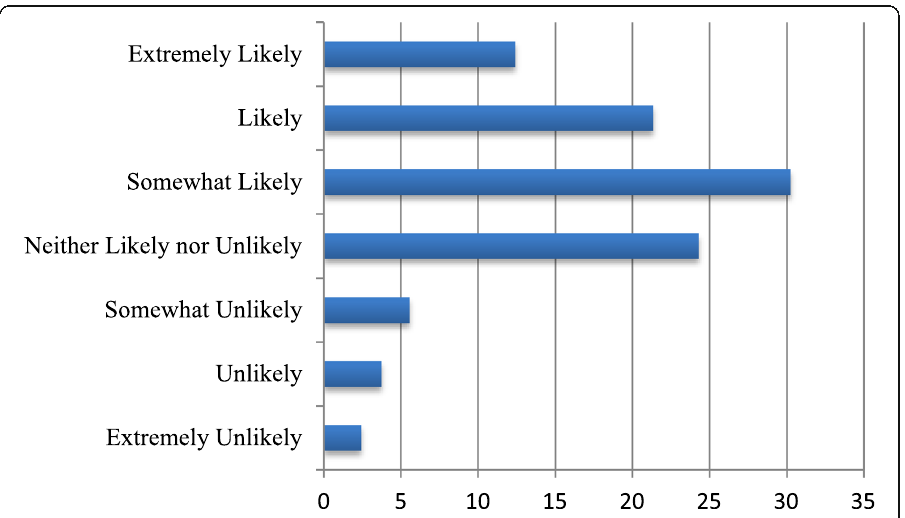
Fig. 7 Intention to purchase ratings: ‘ prolonged maternal feeding ’ (%; pooled all